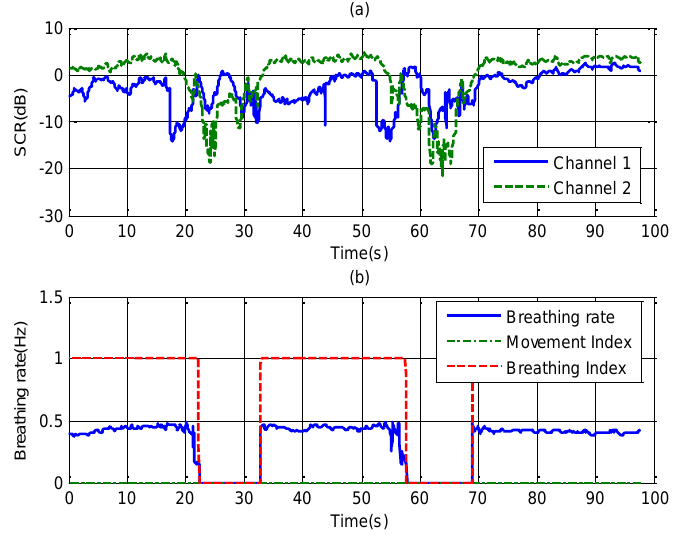
Figure 11. ( a ) Signal to clutter ratio as a function of time for each channel; ( b ) Estimated breathing rate as a function of the time (-), movement index (--) and breathing index (-.), for the case of Figure